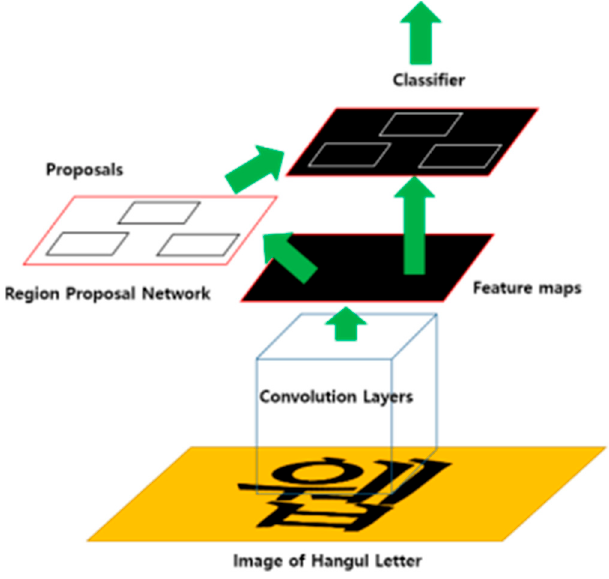
Figure 3. Faster R-CNN structure. Figure 3. Faster R‑CNN